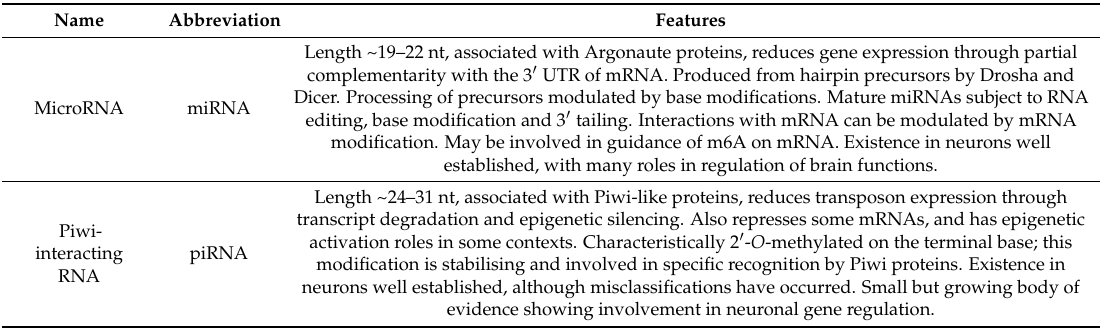
Table 1. Classes of small RNA occurring in the mammalian